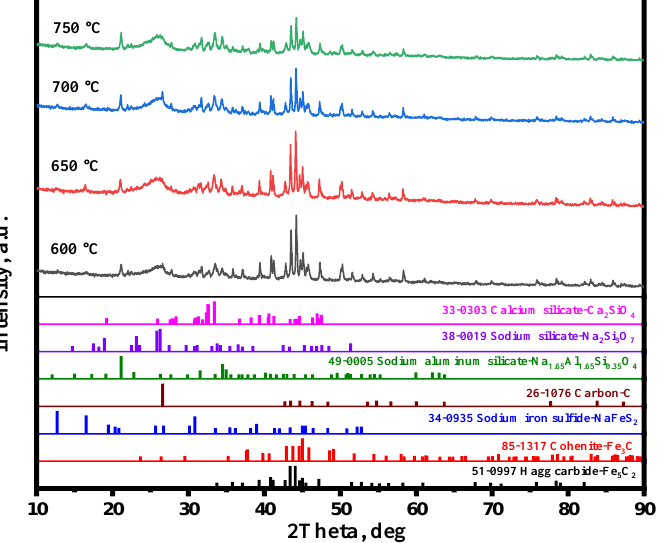
Figure 8. XRD patterns of carburized pellets with different carburization temperatures.